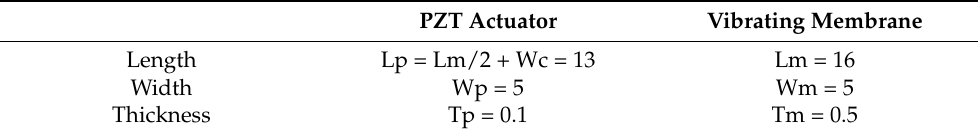
Figure 1. ( a ) Cross-sectional view of the cuboid 3D-printed liquid cell along a symmetry plane with the attached PZT actuators. ( b ) Schematic view with key dimensions defining the vibrating membrane (dimensions are not to scale). Table 1. Key dimensions (in mm) of the PZT actuators and vibrating membrane. Wc is the width of the cell wall anchoring the membrane contour.